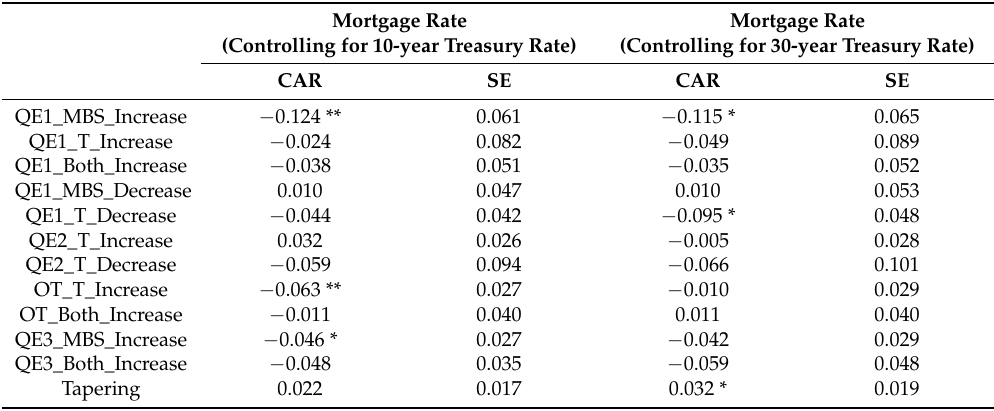
Table A4. Differences in regression results by using 10-year Treasury rate instead of 30-year Treasury rate. Values and standard deviations (SEs) for CAR of mortgage rate from regressions controlling for 10-year Treasury rate and 30-year Treasury rate respectively are